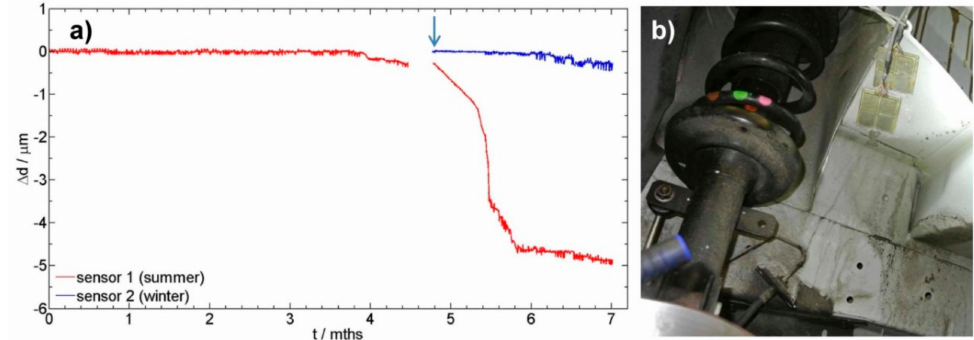
Figure 5. ( a ) The reduction of thickness of the corrosion sensor exposed for 6 months (shown in red), and of the sensor exposed for 2 months (blue curve), and ( b ) position of the 2 sensors exposed for real monitoring in a